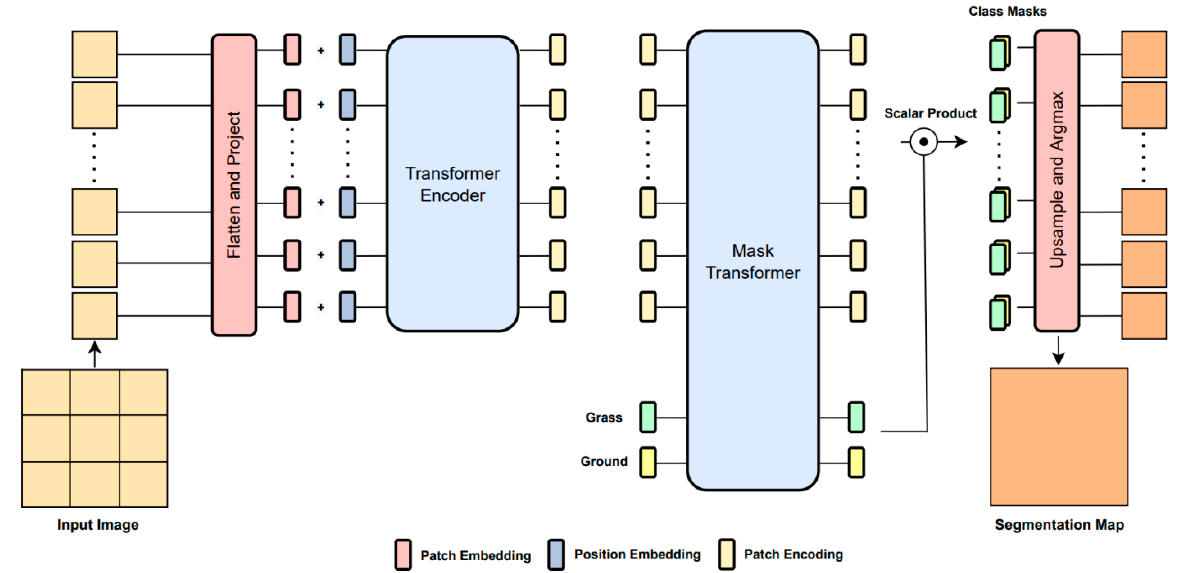
Figure 4. Overall architecture of Segmenter.